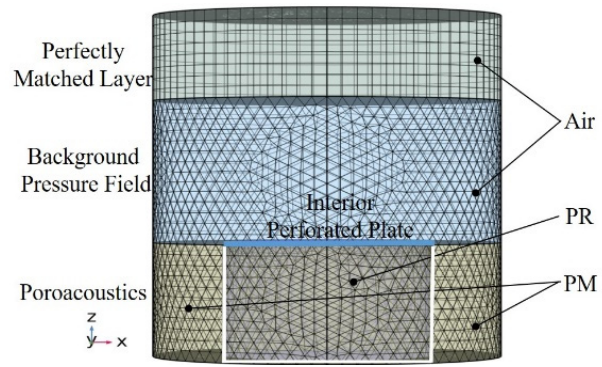
Figure 2. The finite element model of the PPCS.